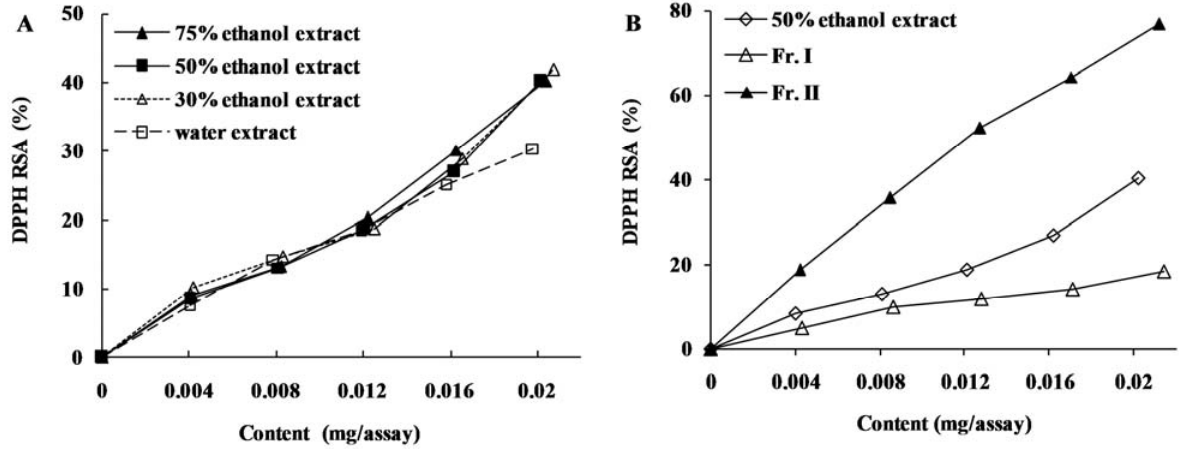
Figure 1. DPPH radical scavenging activity (RSA) of C. mollissima burs extracts ( A ) and fractions ( B ).